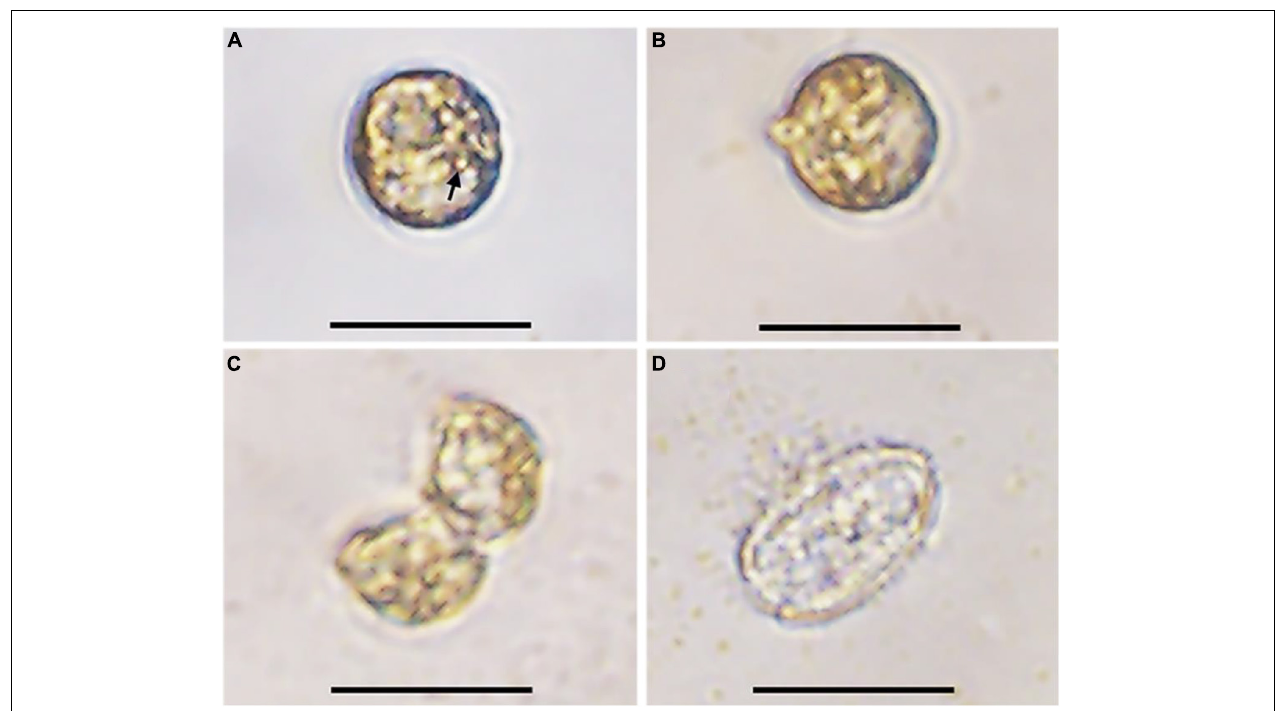
FIGURE 3 | Germination process of a resting cyst of Prorocentrum donghaiense (strain CCMA264) at 21 ◦ C. (A) The resting cyst at day 1 was newly isolated and the accumulation body was clear (arrow); (B) the resting cyst at day 2 was observed with morphological changes; (C) the planomeiocyte division at day 3; (D) the empty cyst with a thick wall observable. Scale bars = 20 µ